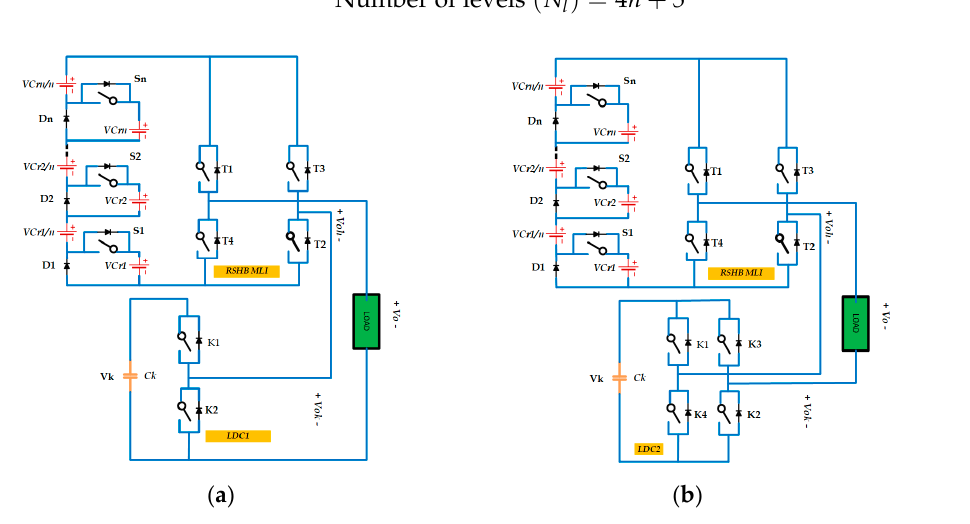
Figure 3. ( a ) 19 − Level MLI; ( b ) 17 − Level MLI.